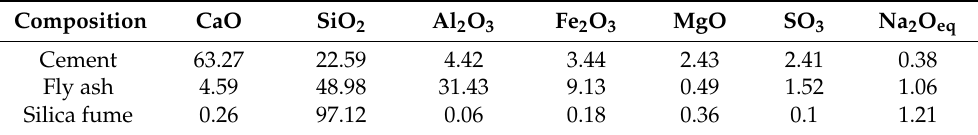
Table 1. Chemical compositions of cement, fly ash and silica fume w /%.